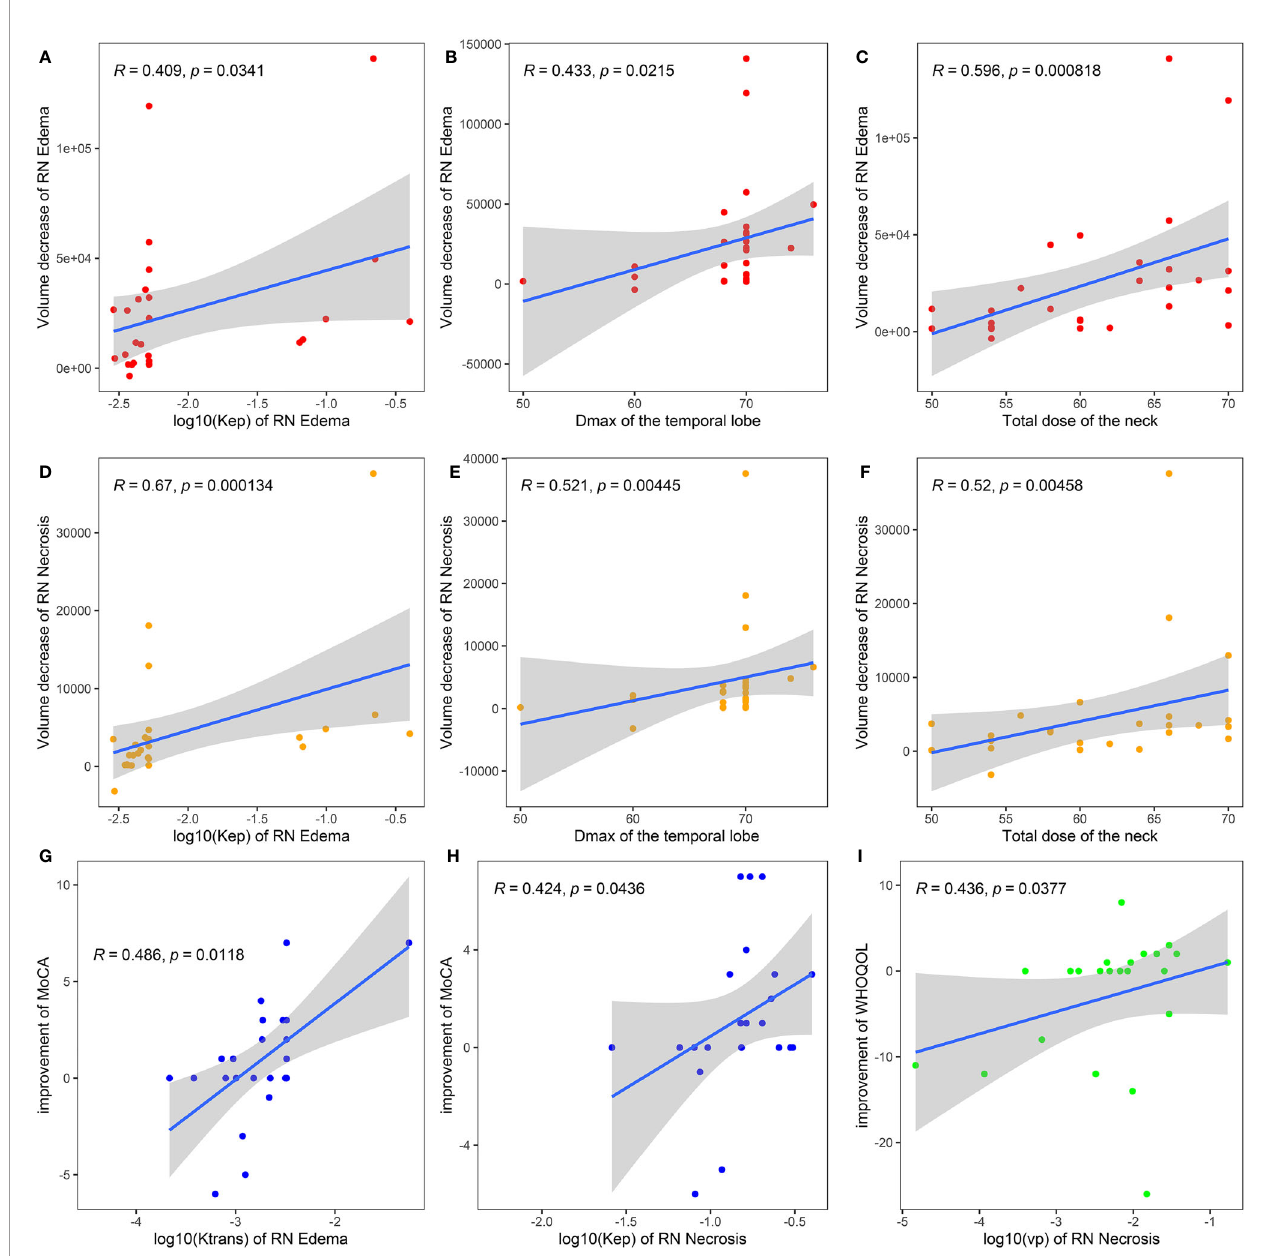
FIGURE 4 | Spearman correlation analysis of baseline DCE parameters of bevacizumab treatment with volume decrease of RN edema (A – C) , RN necrosis (D – F) , and symptomatic improvement scaled by clinical scores (G – I) . D max of the temporal lobe, the maximum radiation dose of the temporal lobe; MoCA, Montreal Cognitive Assessment; LENT/SOMA, the Late Effects of Normal Tissue (LENT)/Subjective, Objective, Management, Analytic (SOMA); WHOQOL, the World Health Organization Quality of Life Instrument/Short Version